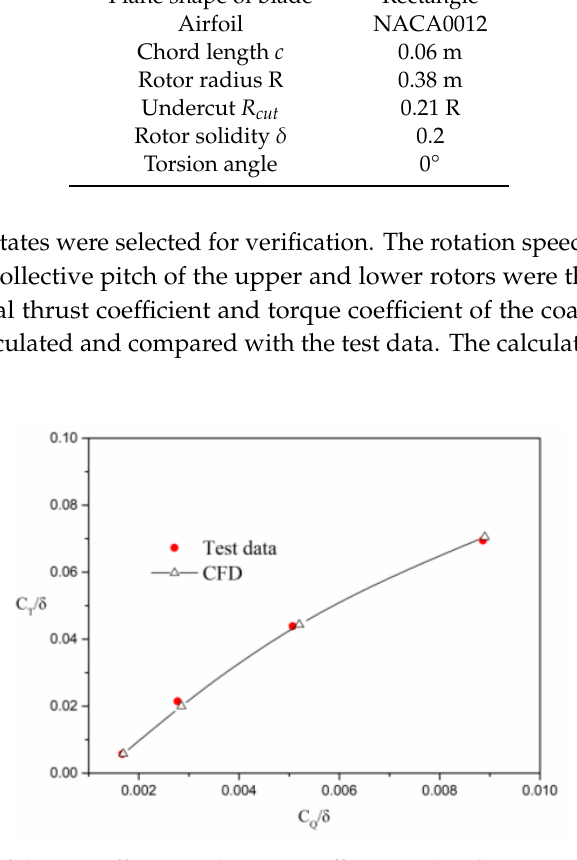
Figure 13. Variation of thrust coefficient and torque coefficient with collective pitch of the coaxial rotor in hover.